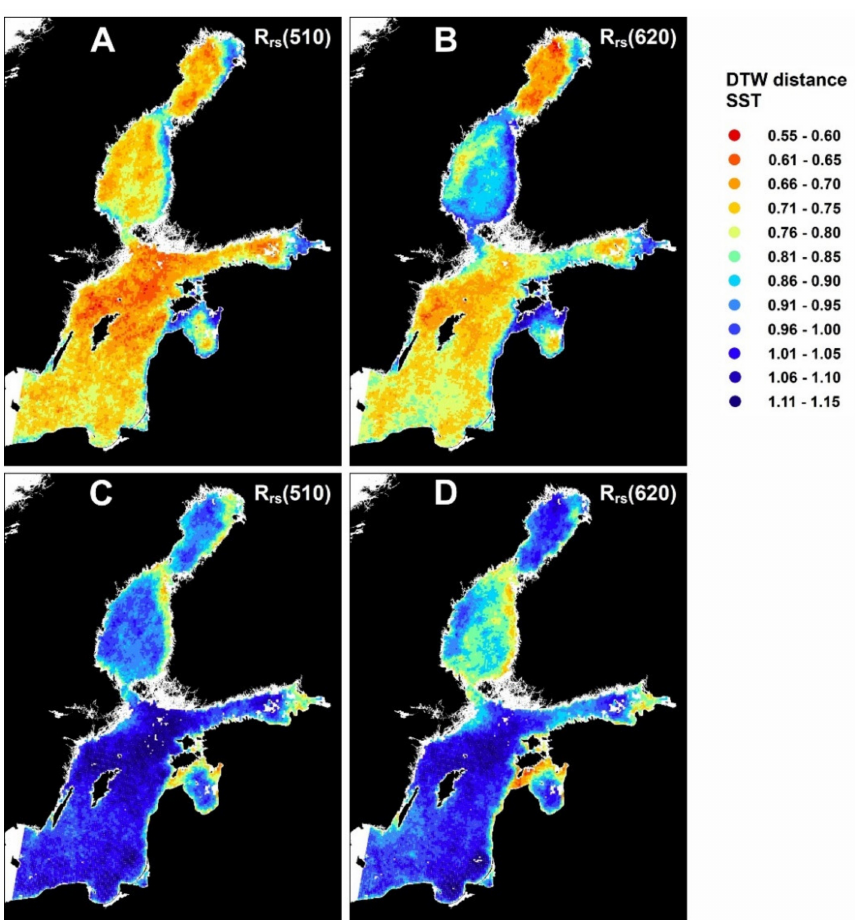
Figure 14. Upper: Time series distances from (standardized) SST change ∆ SST z to R z ( λ ). In reddish areas a change towards warmer SST was more closely followed by an elevated reflectance than in blueish areas. Lower: Time series distances from (standardized) opposite SST change -( ∆ SST z ) to R z ( λ ). In reddish areas a change towards colder SST was more closely followed by elevated reflectance than in blueish areas. ( A ) north wind, ( B ) east wind, ( C ) south wind, ( D ) west